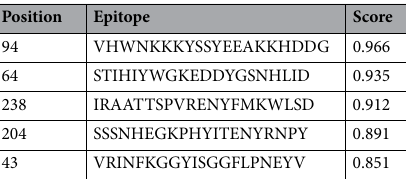
Table 2. List of linear B-cell epitopes with their location and score by using the BCPRED